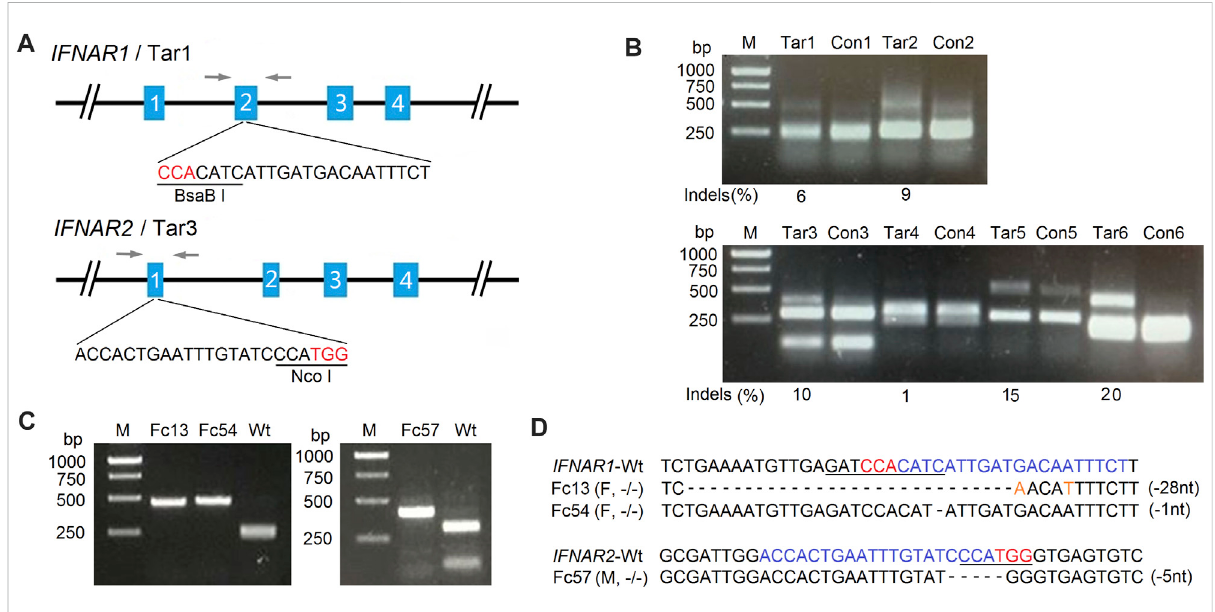
FIGURE 1 Generation of IFNAR1 − / − and IFNAR2 − / − sheep fetal fi broblast colonies for SCNT by CRISPR/Cas9. (A) Schematic diagram of IFNAR1 and IFNAR2 targeting sites. The single-guide RNA (sgRNA) target sequences for each locus are depicted, with the restriction enzyme recognition sites used for PCR-RFLP assays underlined. Letters in red indicate protospacer-adjacent motifs (PAMs). Arrows indicate locations of PCR primers. (B) Gene targeting ef fi ciency analysis of two targeting vectors for the IFNAR1 locus (upper panel) and four targeting vectors for the IFNAR2 locus (lower panel) in SFFs detected by PCR-RFLP assays. M, 1-kb DNA ladder; Con, control (WT SFFs); Tar, SFFs transfected with each targeting vector. The targeted alleles lost restriction sites through error-prone non-homologous end joining (NHEJ) following Cas9-mediated double-stranded DNA breaks. The mutation ef fi ciency (indels) of targeting vector 1 (Tar1) was 6% and of targeting vector 3 (Tar3) was 10%. These are the targeting vectors that were used for the generation of the IFNAR1 − / − and IFNAR2 − / − sheep fetal fi broblast colonies, respectively. (C) PCR-RFLP assays for the detection of IFNAR1 − / − and IFNAR2 − / − single-cell derived SFF colonies with mutations at IFNAR1 (left) and IFNAR2 (right). (D) Sequencing analysis of IFNAR1 − / − and IFNAR2 − / − colonies. Letters in blue indicate sgRNA sequences and orange nucleotides replaced at cleavage sites. M, male; F, female; − / − , both alleles targeted; – 1 nt, one nucleotide